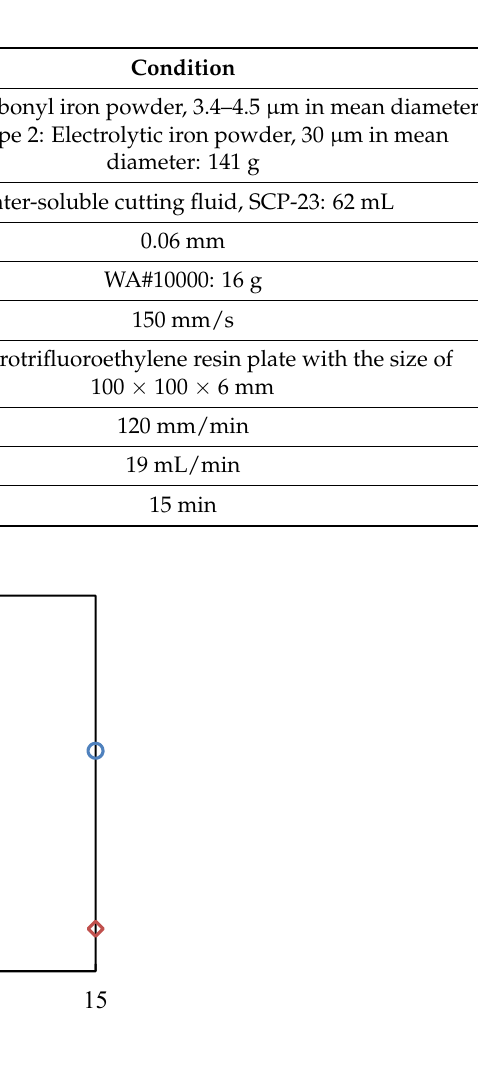
Figure 12. Effects of iron powder particle size on surface roughness.